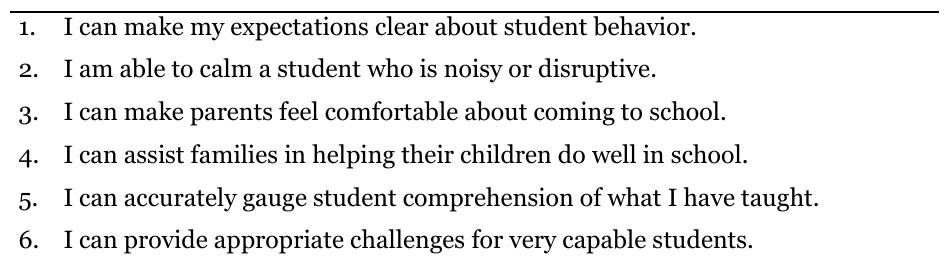
Teacher Efficacy for Inclusive Practices (TEIP) Scale